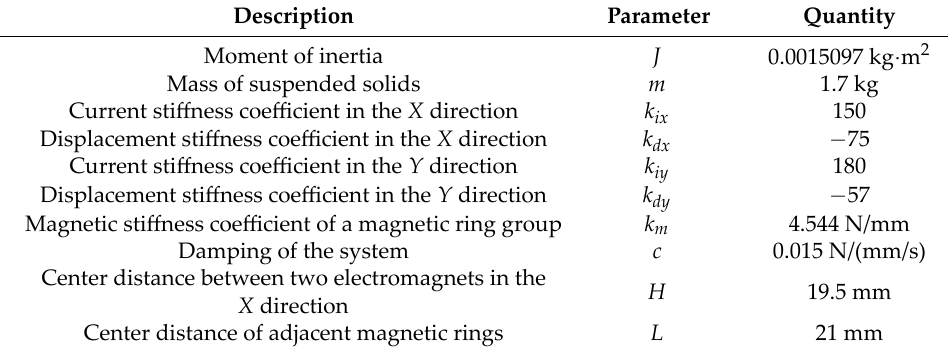
Table 1. System Table 1. System parameters.